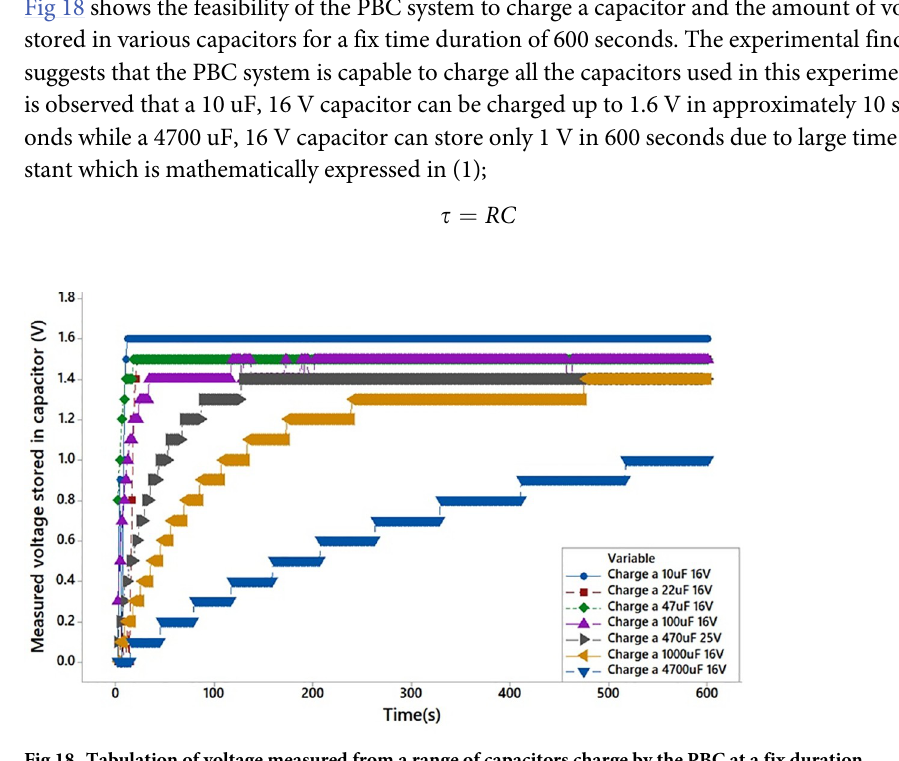
Fig 18. Tabulation of voltage measured from a range of capacitors charge by the PBC at a fix duration.